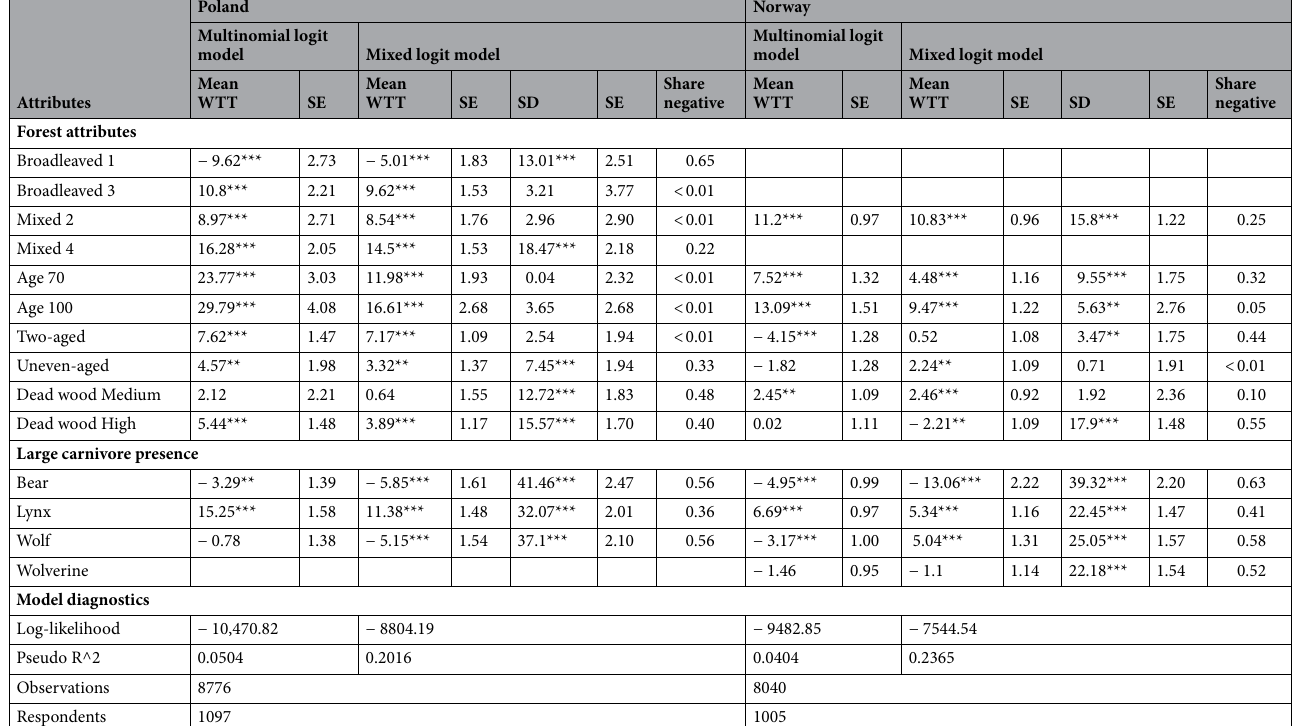
Table 3. Output of the multinomial logit model and mixed logit model assessing respondents’ preferences in relation to forest structural attributes and large carnivore presence in Poland and Norway. Estimates are expressed in willingness-to-travel (WTT, kms). ‘Share negative’ is the proportion of respondents who have negative willingness-to-travel. The levels of significance are as follows: *0.1, **0.05,